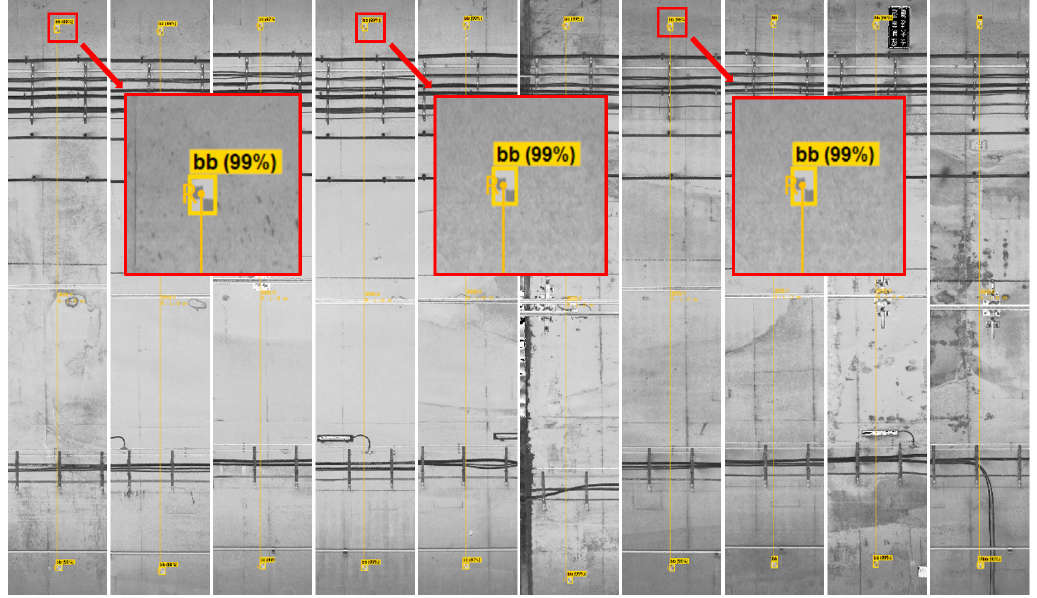
Figure 17. Partial recognition results of some targets.